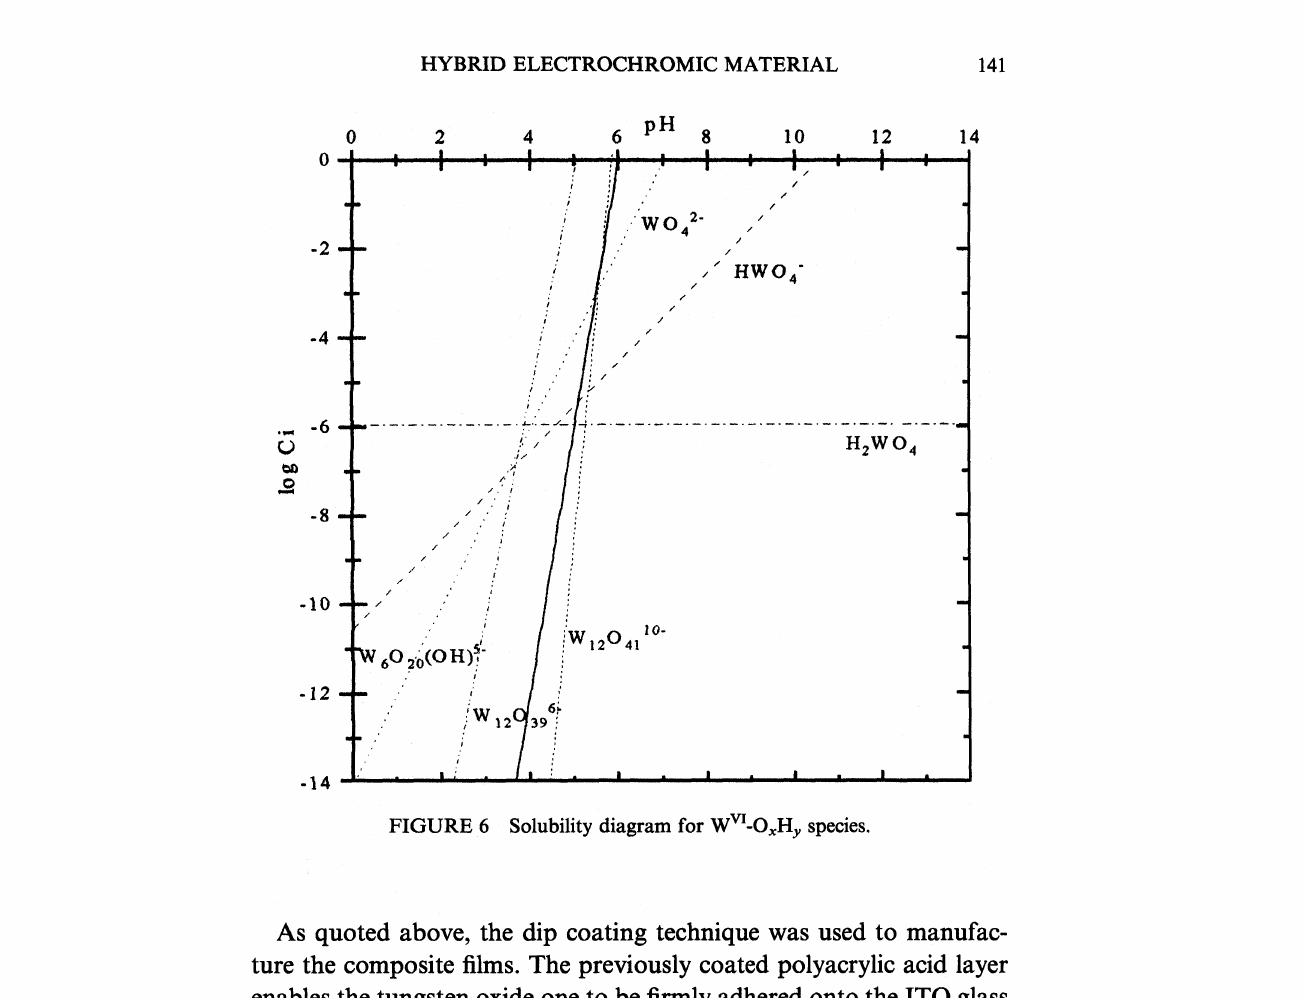
FIGURE 6 Solubility diagram for wVI-o,Hy